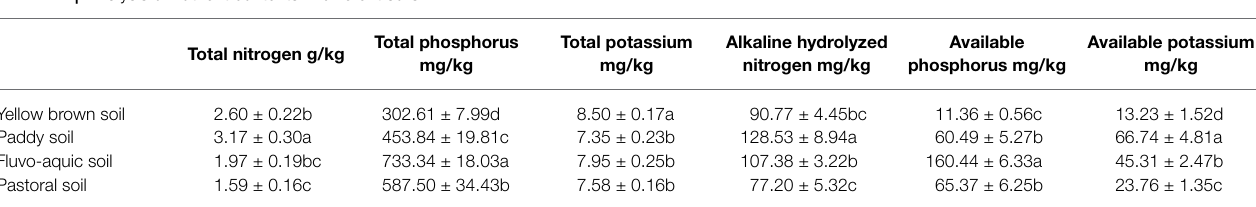
TABLE 2 | Analysis of nutrient contents in different